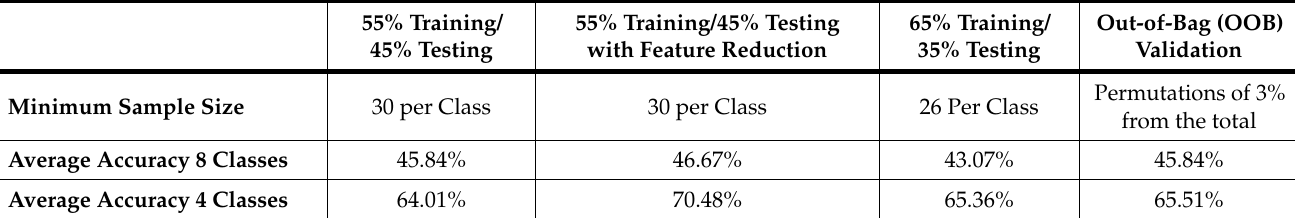
Table 10. Impacts of digital classification training/testing split designs using the RF classifier, UAS imagery, and eight composition classes. Individual Tree Classification Accuracies using the RF classifier, UAS Imagery, and 8 and 4 Composition